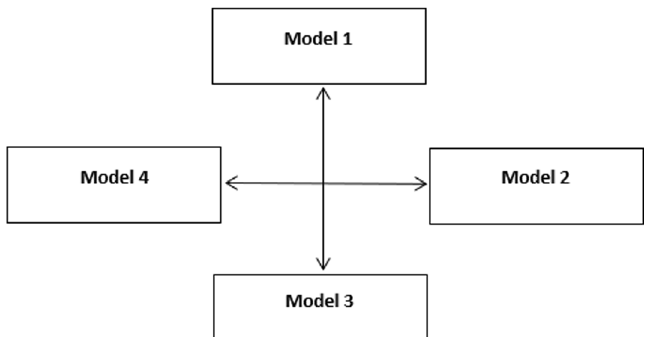
Fig. 13 Impact-relation map for the models